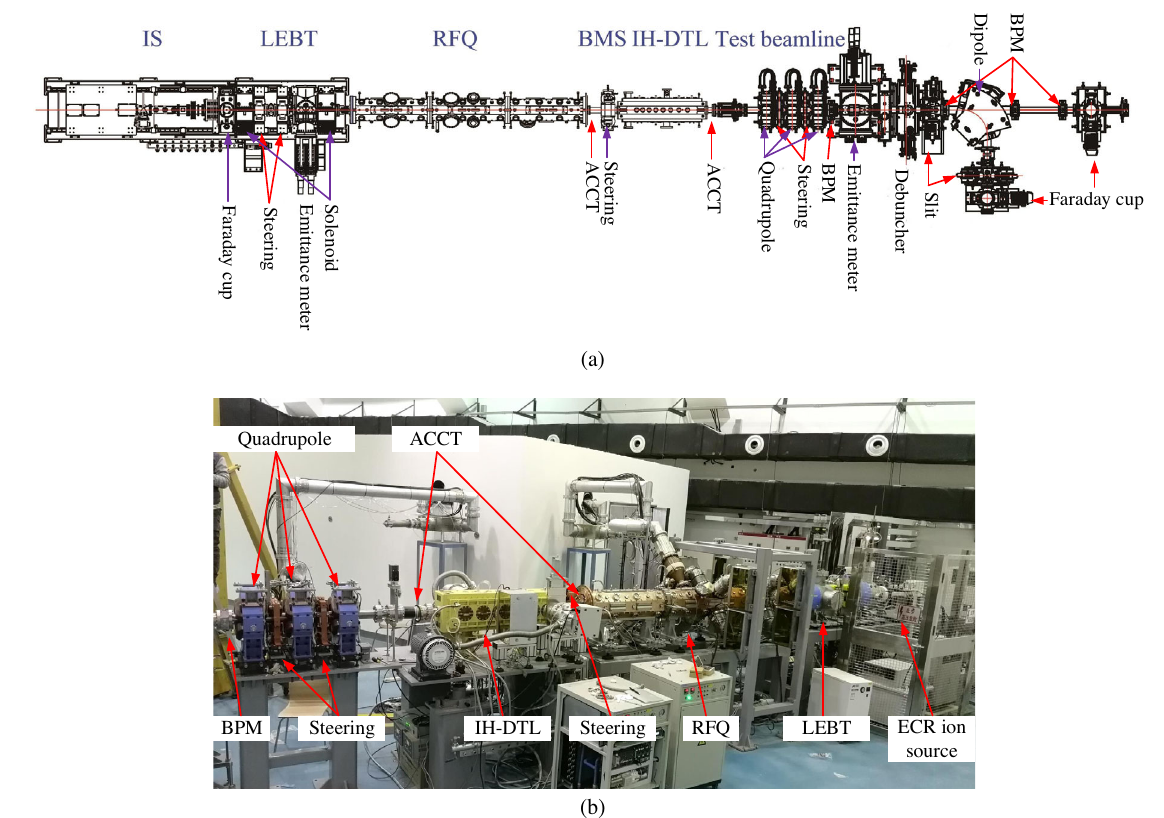
FIG. 8. (a) XiPAF temporary beamline layout. (b) XiPAF temporary beamline from ion source to exit of IH-DTL.